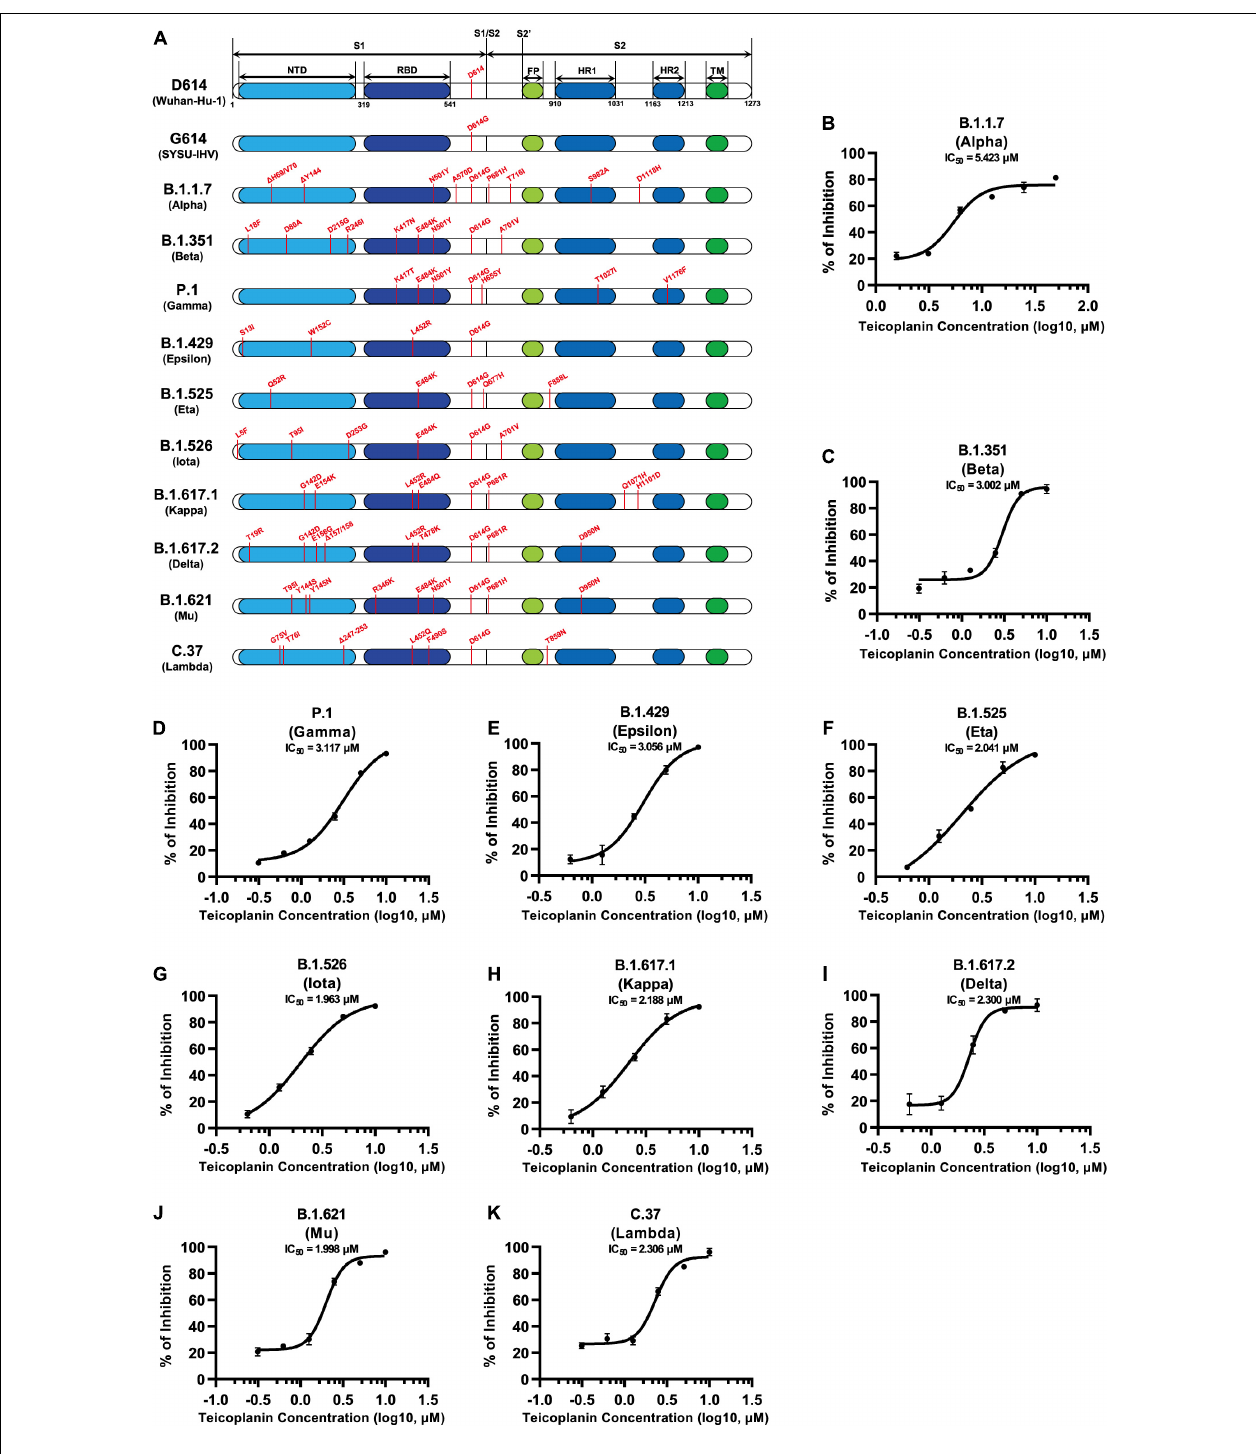
FIGURE 5 | Teicoplanin inhibited the entry of various SARS-CoV-2 mutants. (A) Schematics of the S proteins of 12 different SARS-CoV-2 mutants which included D614 (Wuhan-Hu-1), G614 (SYSU-IHV), B.1.1.7 (Alpha), B.1.351 (Beta), P.1 (Gamma), B.1.429 (Epsilon), B.1.525 (Eta), B.1.526 (Iota), B.1.617.1 (Kappa), B.1.617.2 (Delta), B.1.621 (Mu), and C.37 (Lambda). The mutation sites were shown alongside each backbone and indicated in red. (B–K) HEK293T-hACE2 high cells were co-incubated with different pseudotyped SARS-CoV-2 S/HIV-1 viruses and serially diluted teicoplanin. The amounts of luciferase within each group were measured 48 h post infection and represented as luminescence units. The IC 50 of teicoplanin against these pseudotyped SARS-CoV-2 mutants was calculated based on the amounts of luciferase within each group ( n = 3). Data in (B–K) represented as mean ± SEM in triplicate. Inhibition curves were generated by log (inhibitor) vs. response non-linear